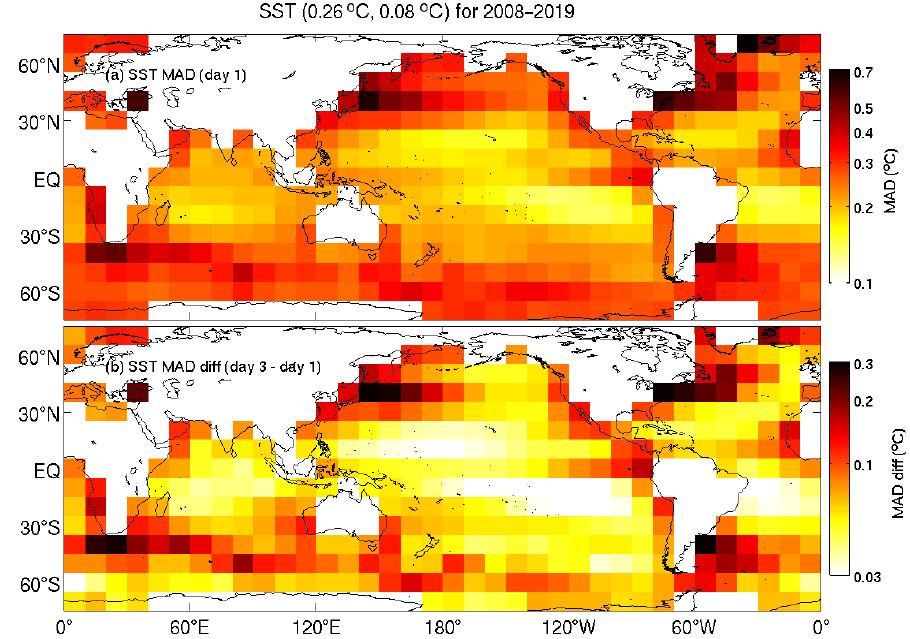
Figure 4. Binned SST mean absolute deviations, averaged over 2008–2019 from the first day (a) and day 3 minus day 1 (b) .